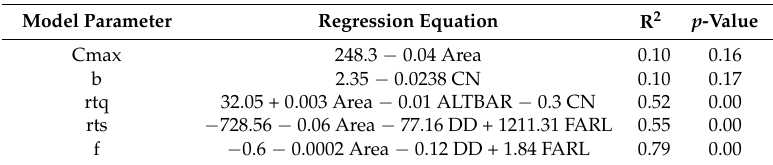
Table 7. The conventional regression equations for PDM model parameters when using C4 as the validation catchment.